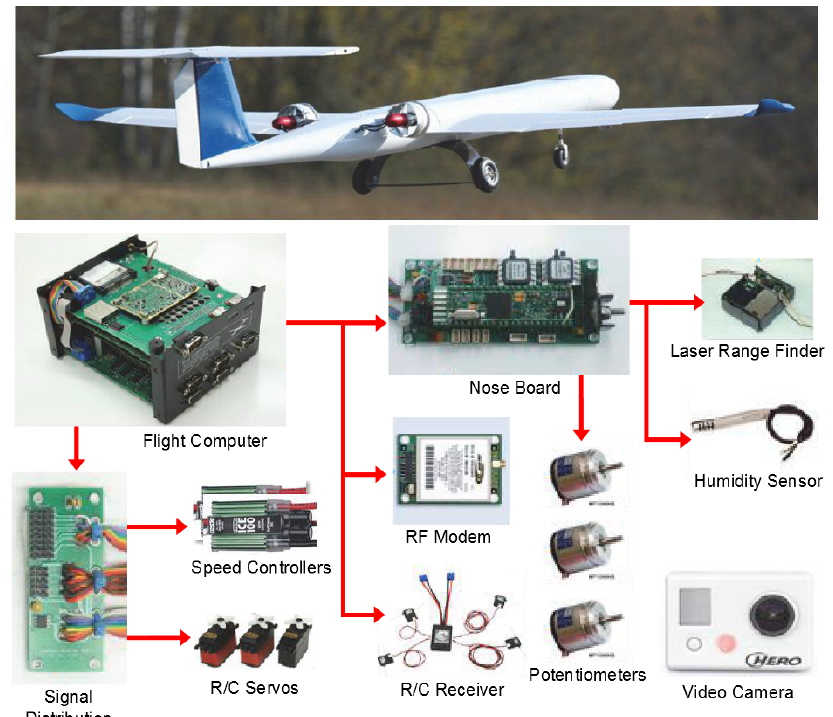
Figure 1. “Phastball” aircraft and its main avionics